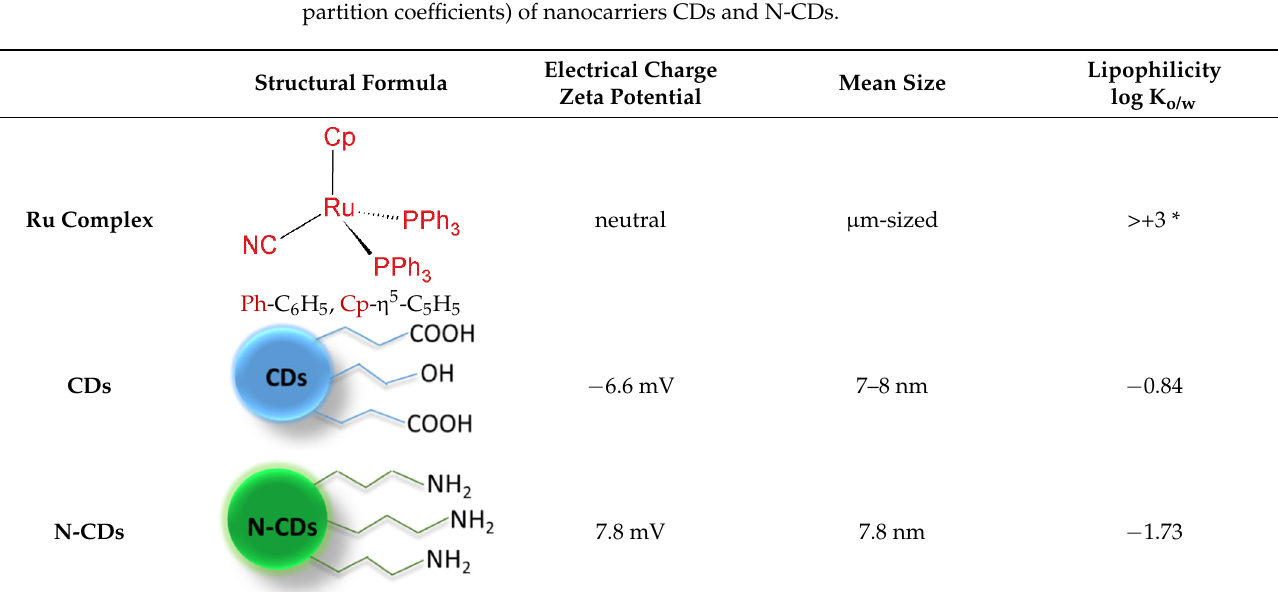
Table 1. Molecular representation and physicochemical properties (zeta potential, mean size, and partition coefficients) of nanocarriers CDs and N-CDs.